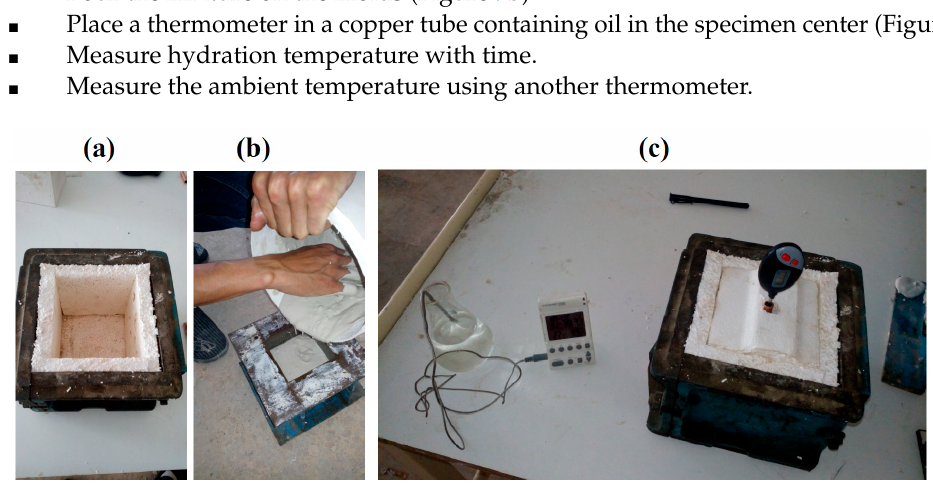
Figure 9. Measurement of hydration temperature: ( a ) Preparation of insulating cubic mold, ( b ) Molds casting, ( c ) Thermometer